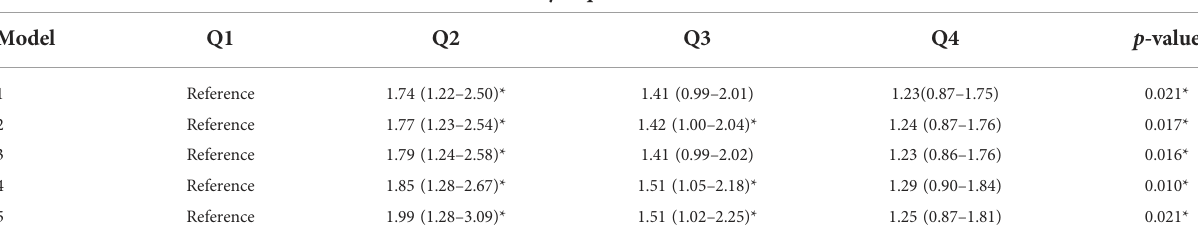
TABLE 3 Odds ratios (95% con fi dence intervals) for triglyceride – glucose (TyG) and carotid plaque in the high-stroke-risk population.